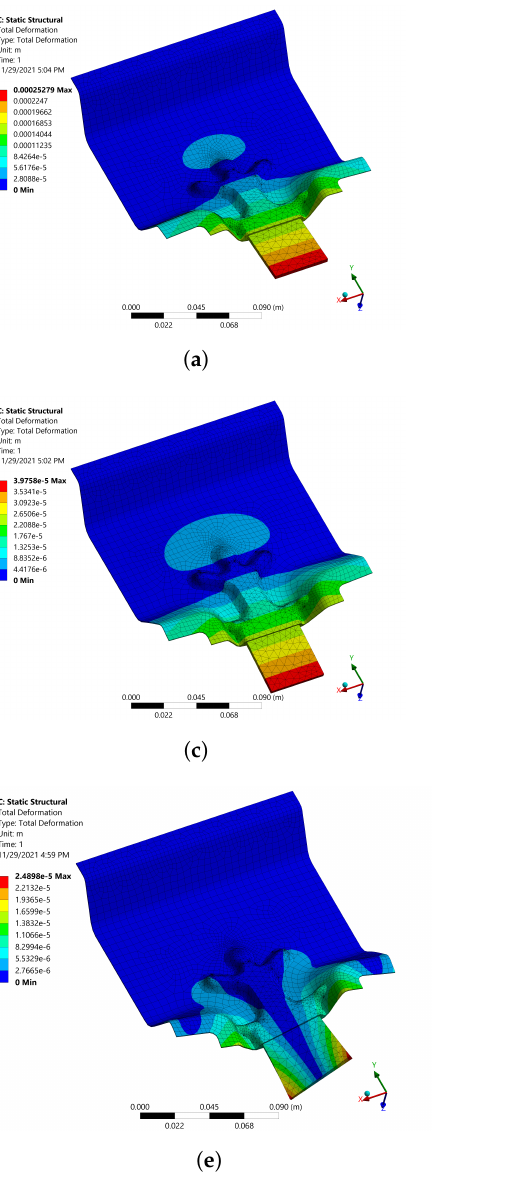
Figure 5. Total deformation of the metal-composite-hybrid structure: ( a ) bending; ( b ) compression; ( c ) traction load; ( d ) lateral bending; ( e )